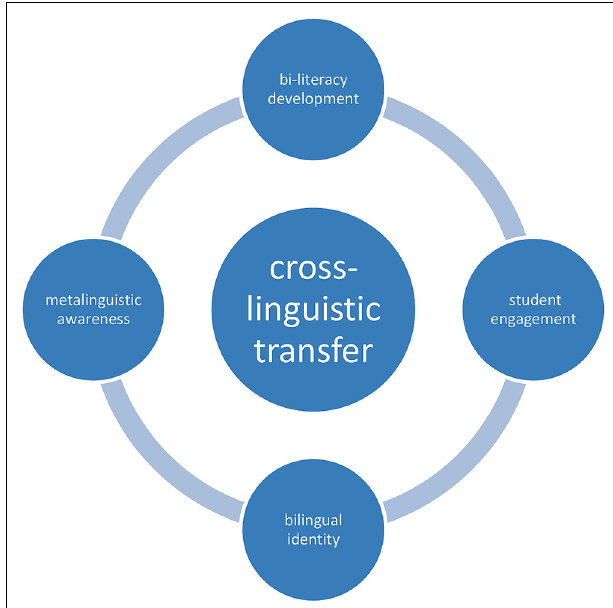
FIGURE 1 | Conceptual framework for 50–50% bilingual pedagogy, diagramming the centrality of cross-linguistic transfer in relation to linguistic interdependence and bilingual